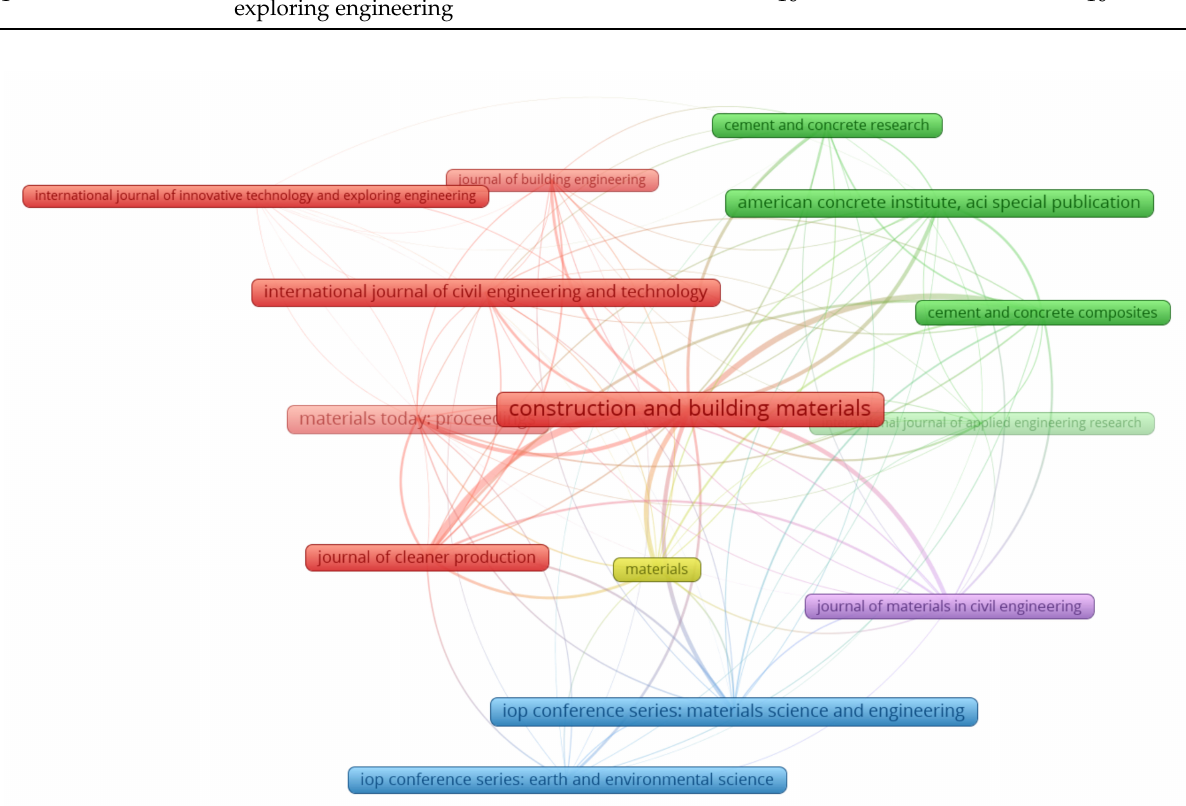
Figure 6. Scientific visualization of publication sources with at least ten publications in the related research